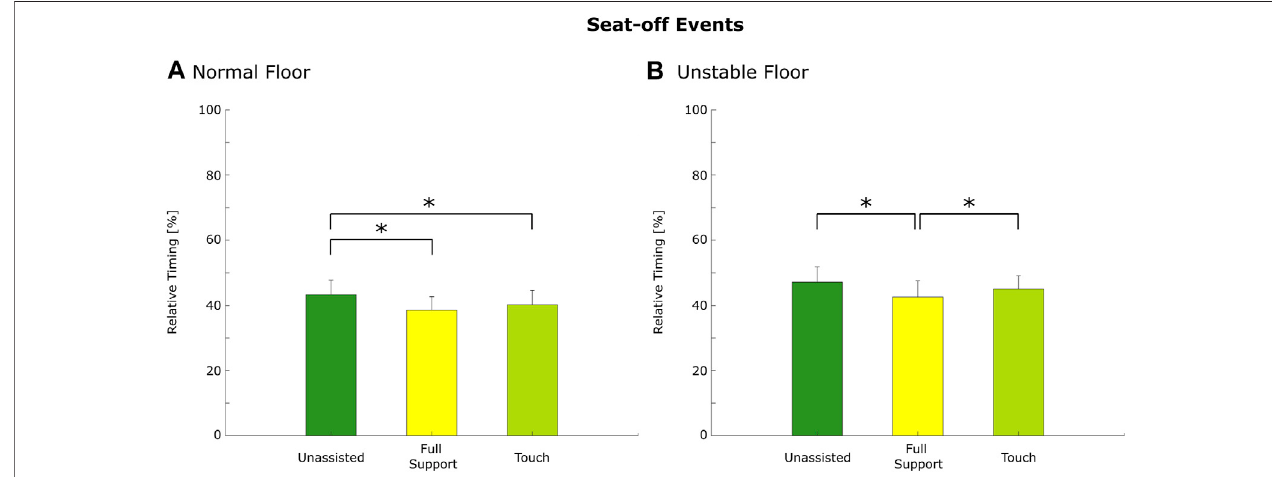
FIGURE 2 | The relative timing of seat-off on normal (A) and unstable (B) fl oors. The bar represents the mean value, the error bar represents the standard deviations, and the asterisk depicts post hoc signi fi cant differences with p ≤ 0.05 (Holm – Bonferroni corrected).